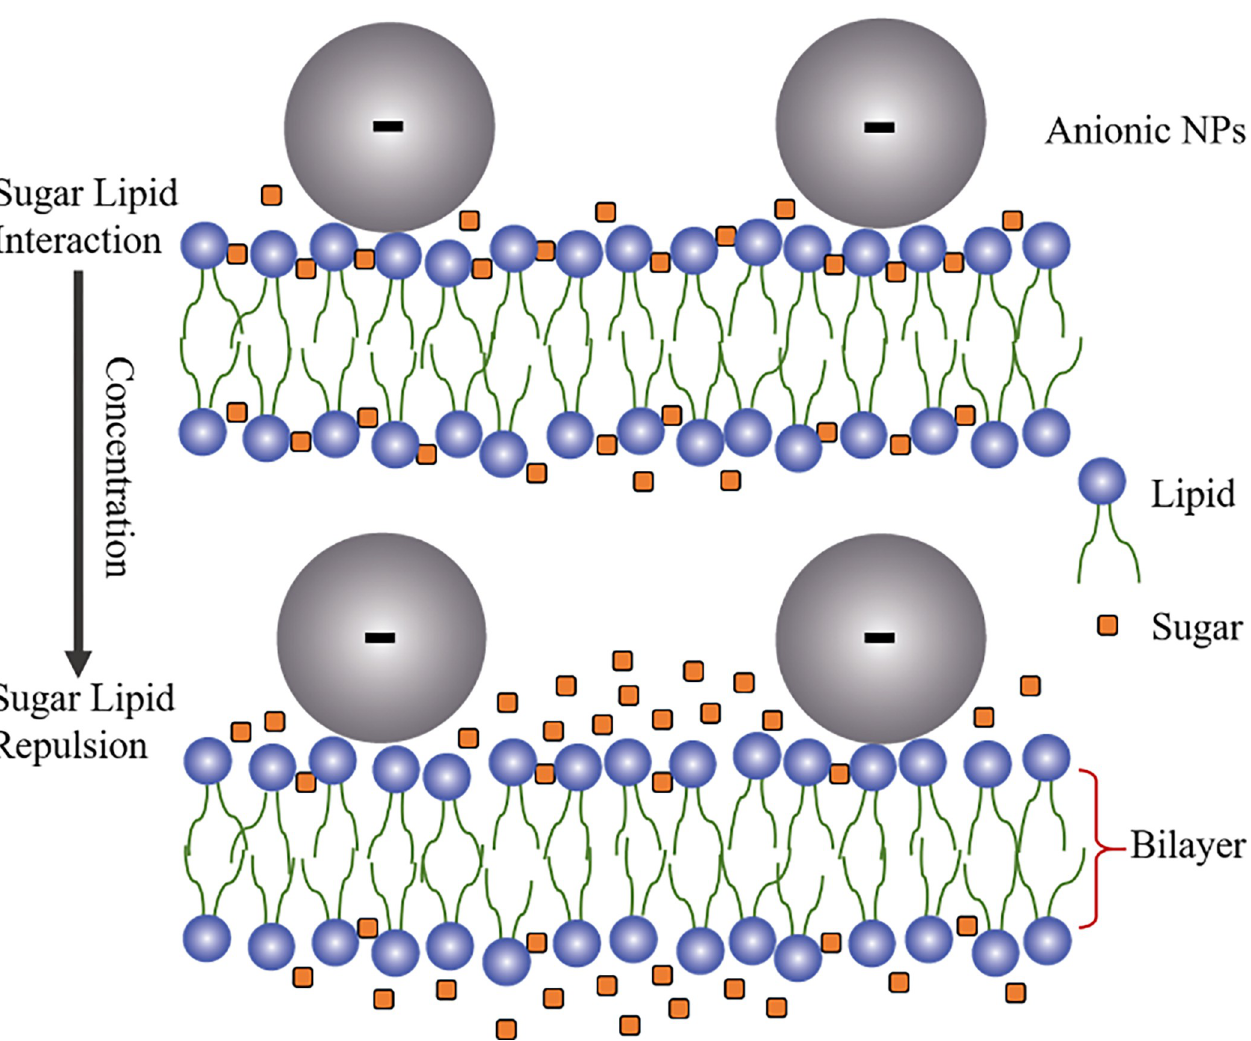
Fig 9. Effects of sugar molecules at lower and higher concentrations in the lipid bilayer for a specific concentration of NPs. The sugar-lipid head groups attractive interaction at lower sugar concentration is attributed to the enthalpy-driven interaction. At higher sugar concentrations, however, the sugar-lipid head groups repulsion is attributed to entropy-driven repulsion. The number density of bound sugar molecules at the interface of lipid molecules in the membrane is higher at lower sugar concentrations than that of higher ones. The sugar molecules at higher sugar concentration are repelled by the lipid